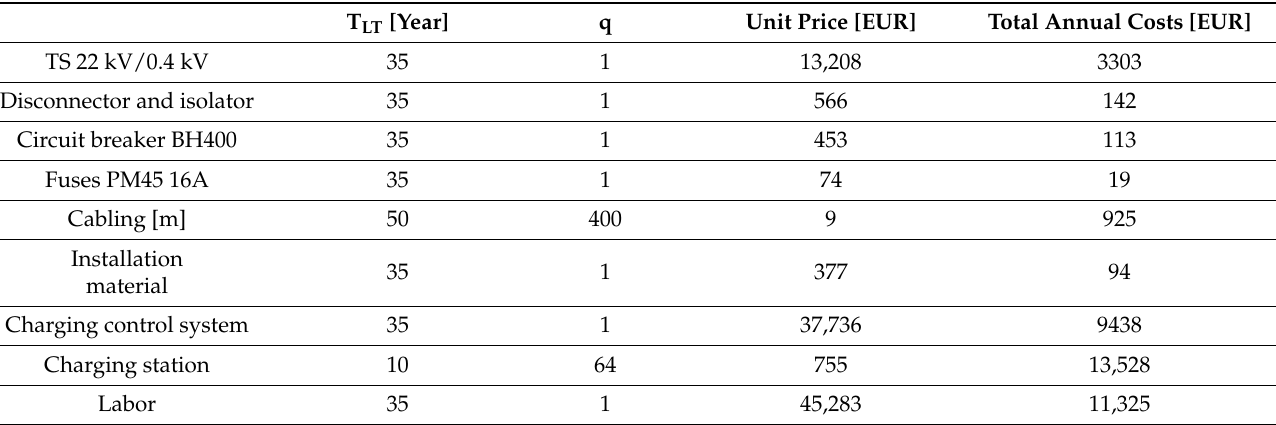
Table 1. Investment